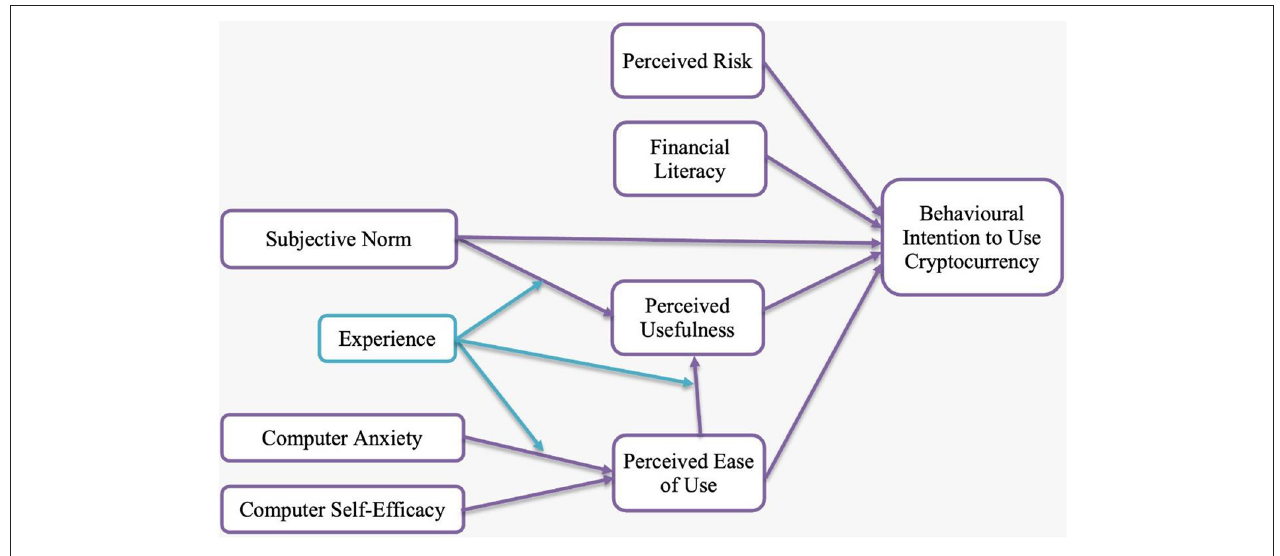
FIGURE 1 | Theoretical framework.